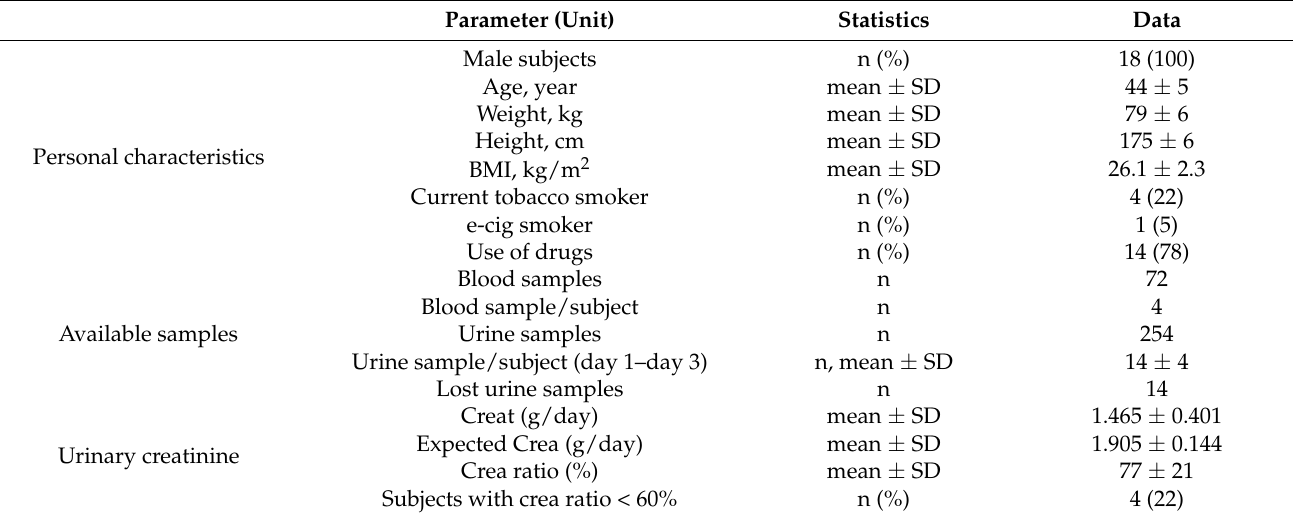
Table 1. Summary of characteristics of study subjects, available samples and urinary creatinine. Parameter